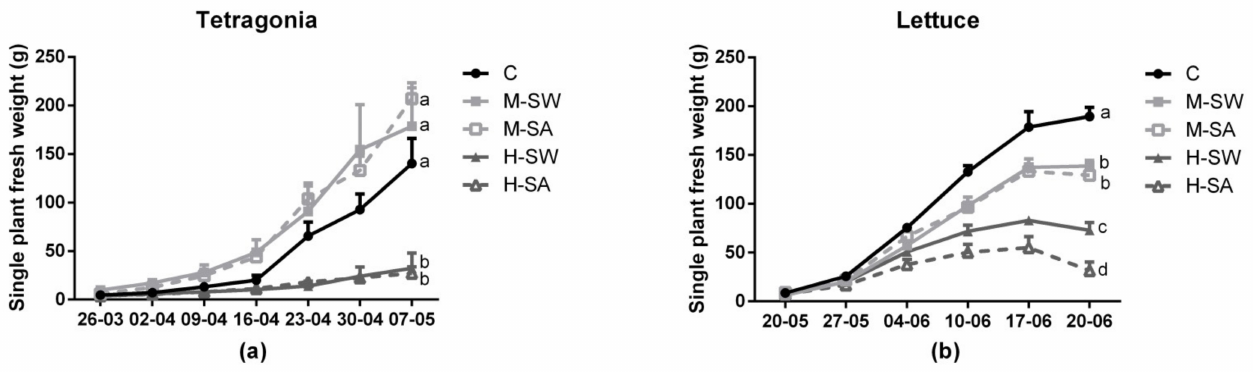
Figure 1. The fresh weight of whole Tetragonia ( a ) and lettuce ( b ) plants. Values are single plants’ weight means ( n = 4) ± SEM expressed in grams. Different letters at the final sampling indicate significant differences assessed at p < 0.05 (Tukey’s test).